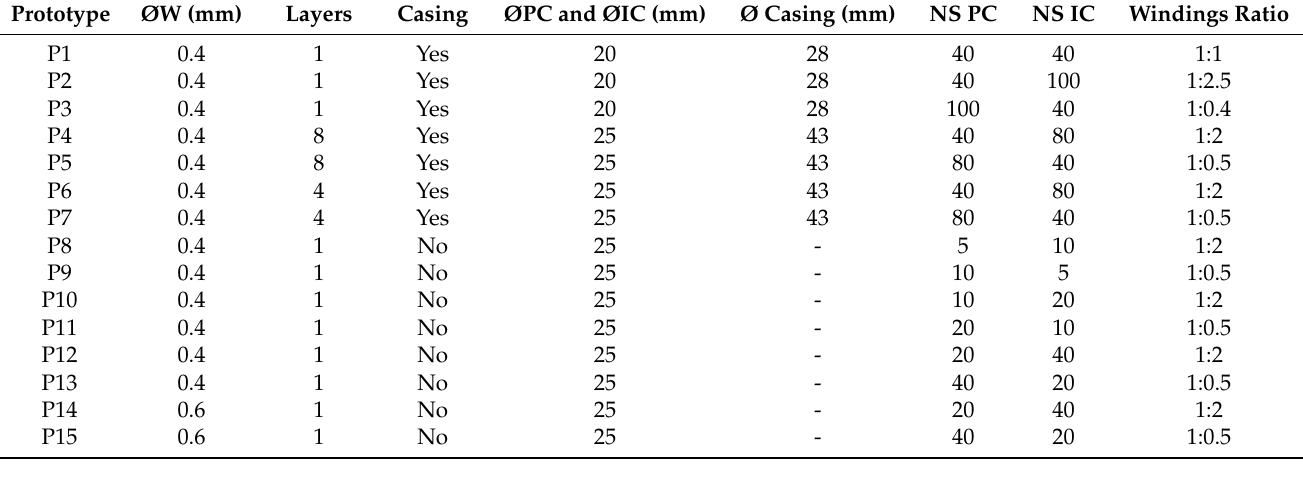
Table 1. Features of the different prototypes for the initial tests.